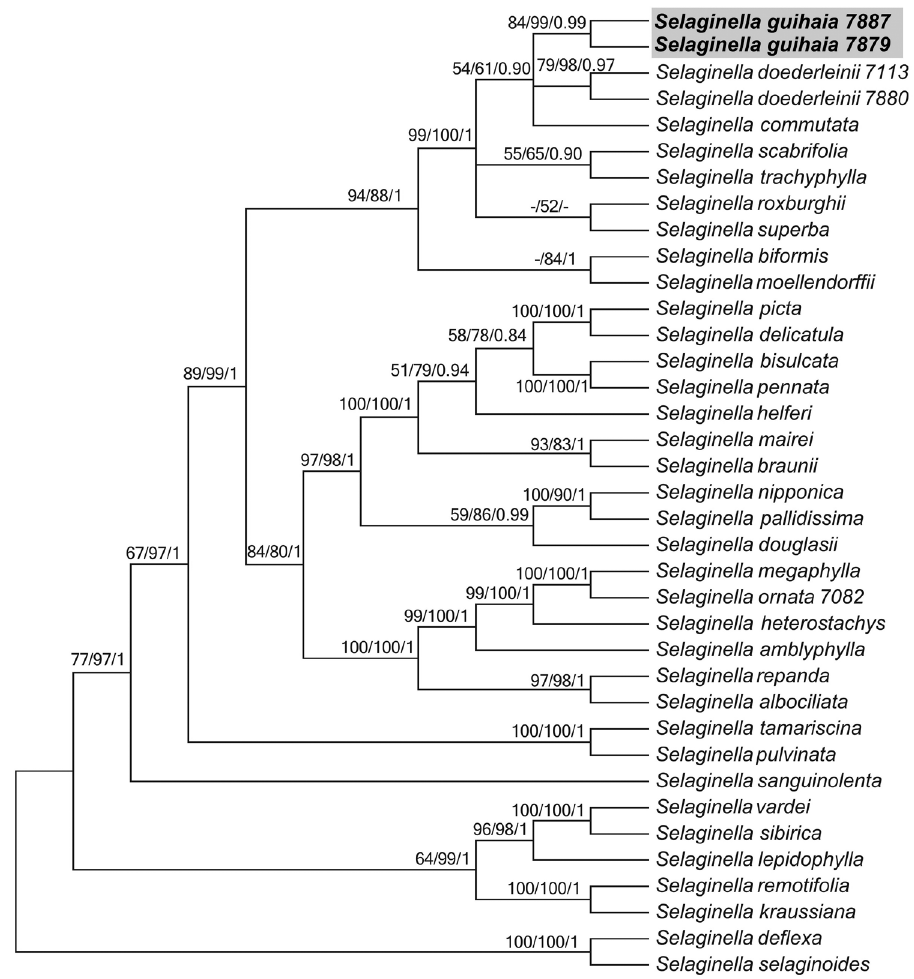
Figure 1. The 50% majority rule consensus tree derived from maximum likelihood showing the position of Selaginella guihaia . Support values (MP the dash (–) indicates BS < 50%. The new species is shown in